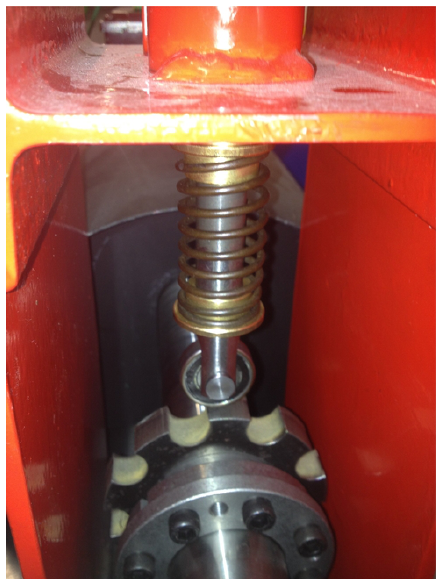
Figure 8. Fault emulator.